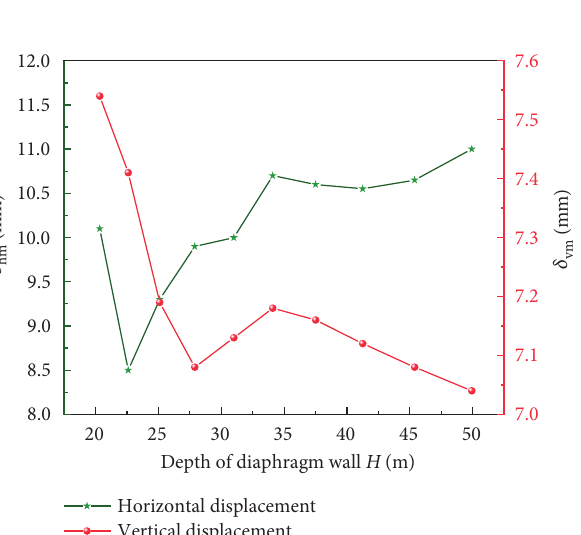
Figure 15: Vertical and horizontal displacements of the station floor structure near the foundation